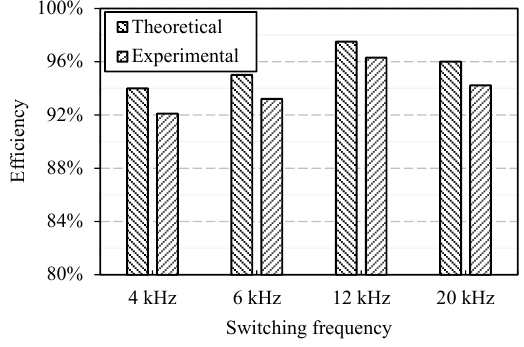
Figure 17. Transmitted active power vs. switching frequency.